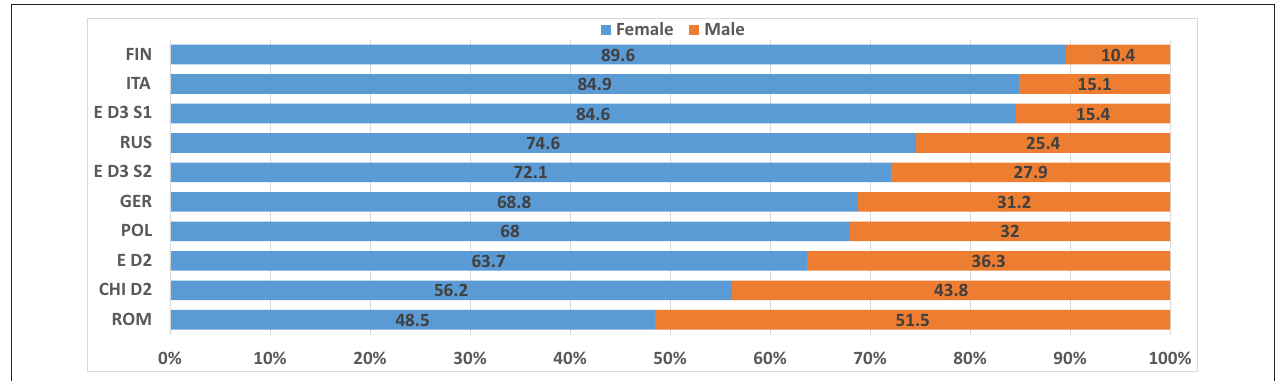
FIGURE 3 | Gender ratio of RAT datasets in the different languages.